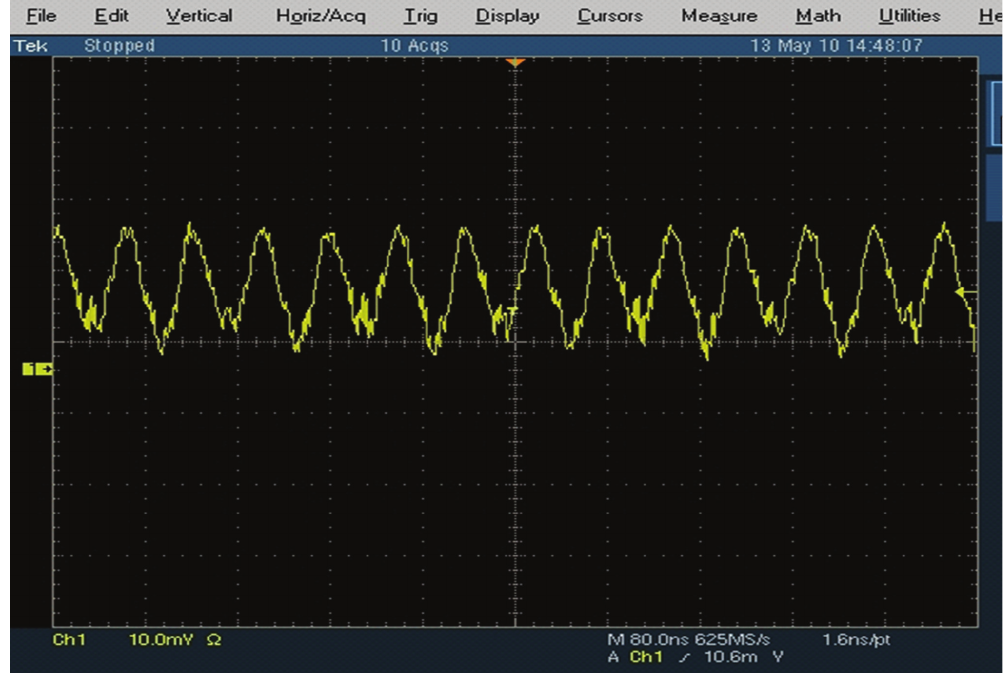
Figure 9: Output of the laser obtained from the